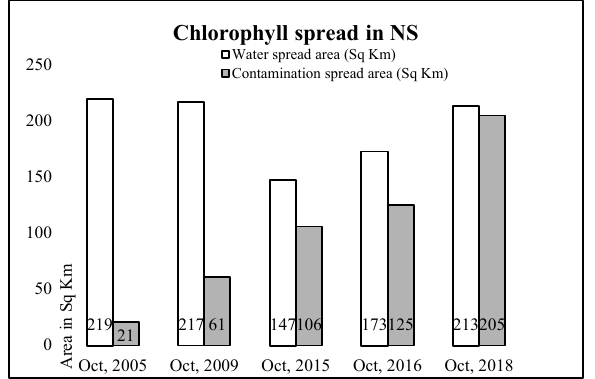
Figure 6: Shows the statistics of NS surface area and chl-a spread area in Sq Km.